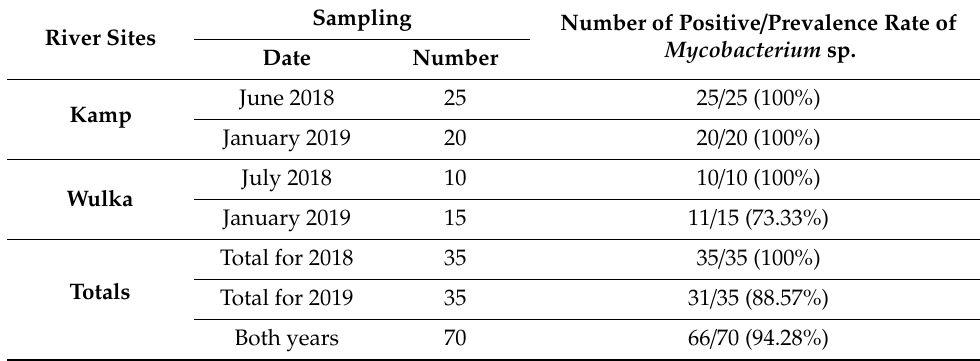
Table 1. Mycobacterium sp. identified in water sample in Austrian